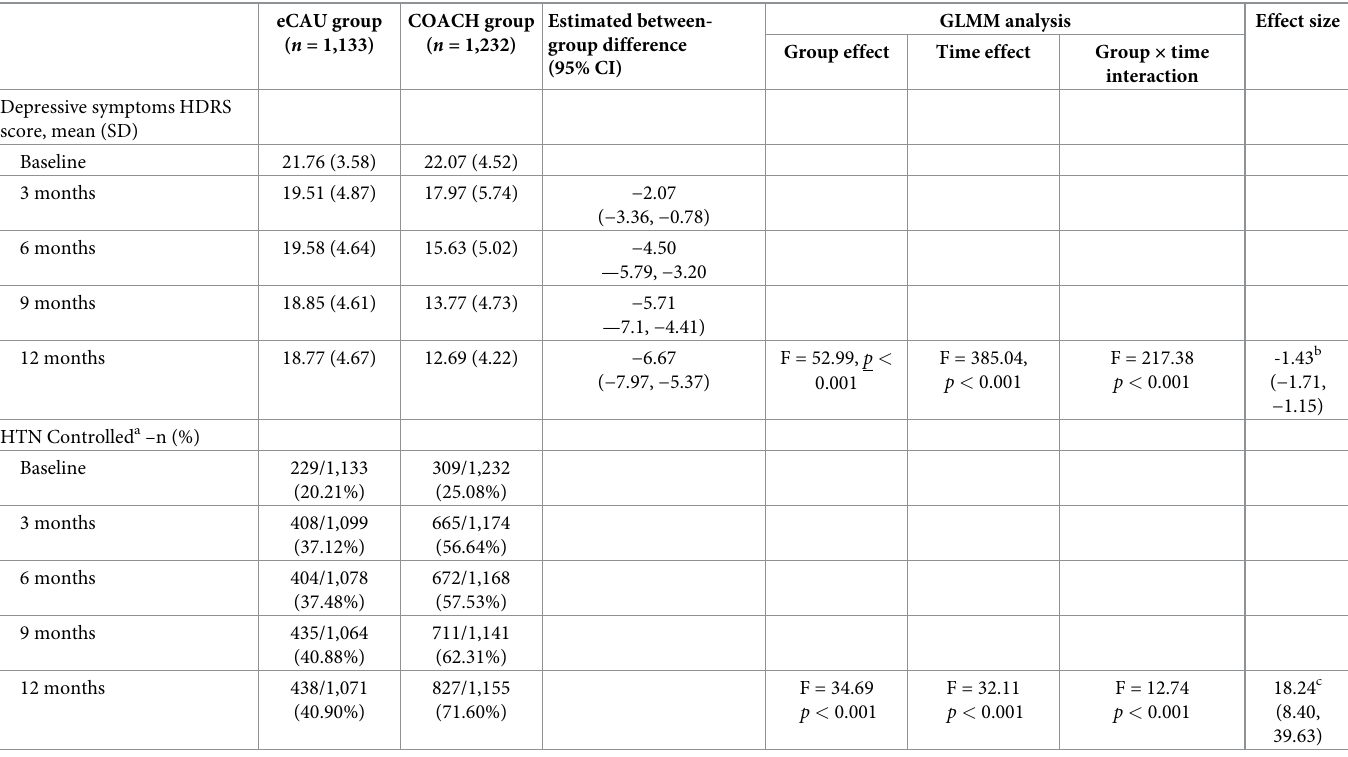
Table 2. Depression and HTN outcomes in eCAU and COACH